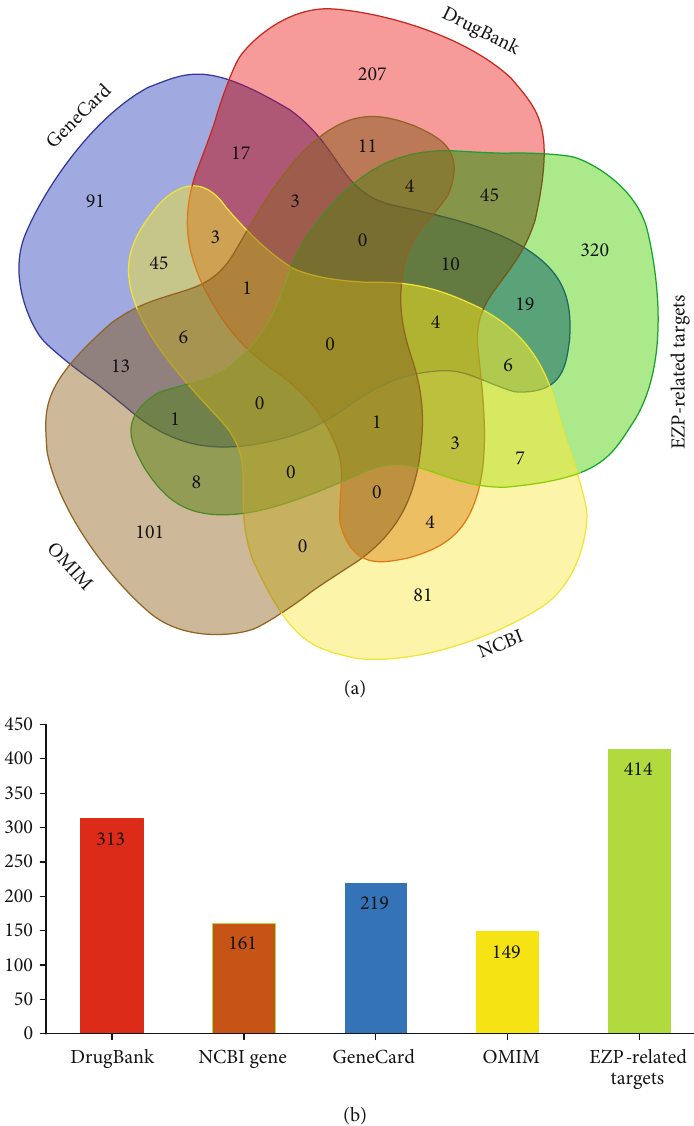
Figure 2: Analysis of predicted MAFLD genes. (a) Venn graph showing the numbers of overlapping genes from DrugBank (red), NCBI Gene (brown), GeneCard (blue), OMIM (yellow), and EZP-related targets (green). (b) The number of predicted genes from each